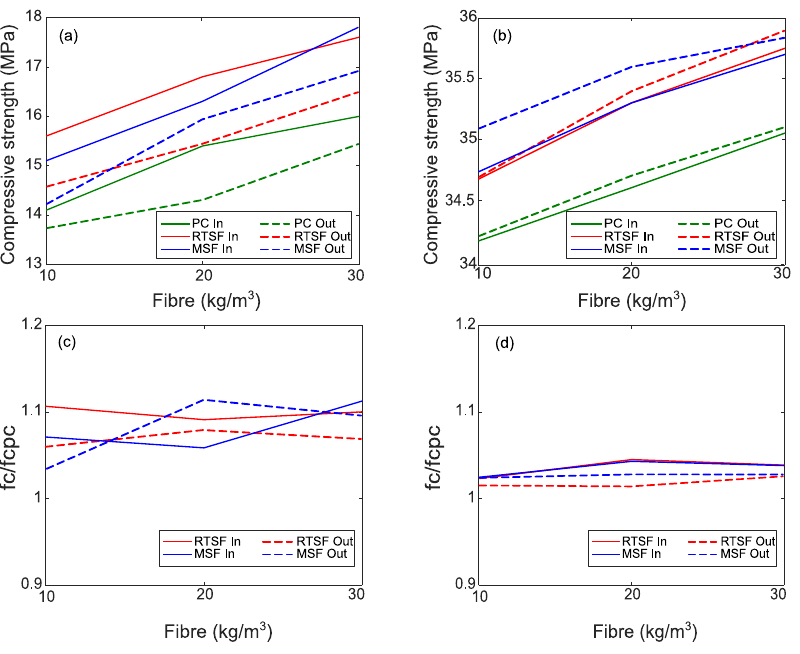
Figure 14. Compressive strength and normalized ratio of PC and FRC at 1 day ( a , c ) and 28 days ( b , d ) for cubes inside (In) and outside (Out) the chamber.